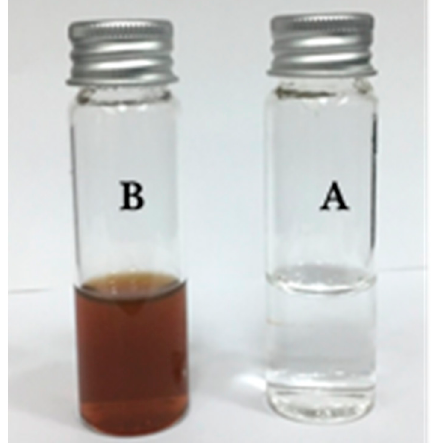
Figure 1. Color and appearance changes during synthesis of silver nanoparticles (Ag NPs) using J. regia leaf extract. J. regia leaf extract containing silver nitrate before ( A ) and after ( B ) exposure to microwave irradiation.